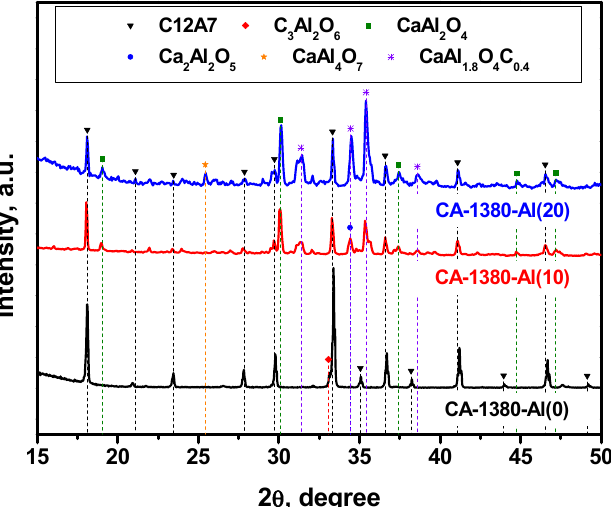
Figure 5. XRD patterns for the mayenite samples with varied content of aluminum additive after calcination in an Ar atmosphere at 1380 ◦ C. Table 3. Lattice parameter ( a ), phase composition, and specific surface area (SSA) of the mayenite samples calcined in an Ar atmosphere at 1380 ◦